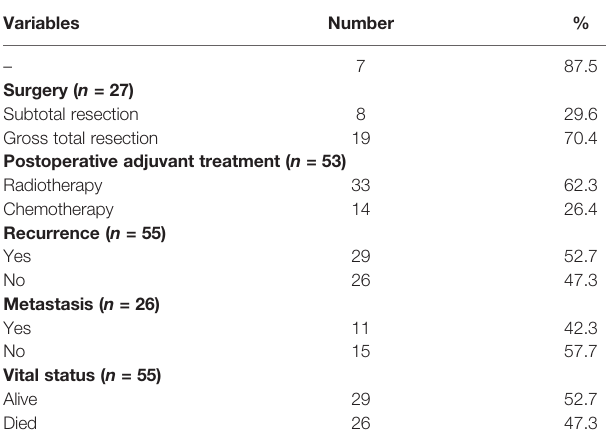
TABLE 4 | The summary of patient